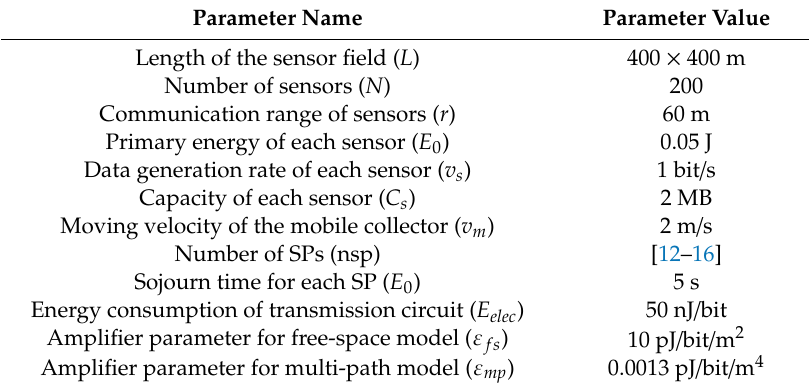
Table 3. Network